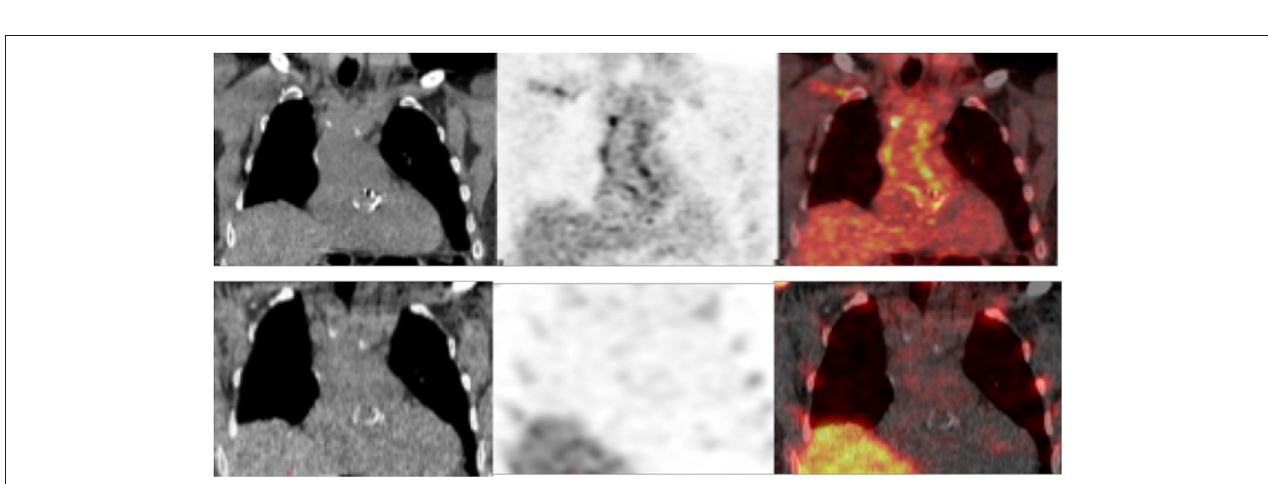
FIGURE 6 | Examples of discordant findings between [ 18 F]FDG PET/CT (upper panel, coronal view from left to right CT, emission and superimposed PET/CT) and 99m Tc labeled hexamethylpropylene amine oxime-WBC ( 99m Tc-HMPAO-WBC) (lower panel, coronal view from left to right CT, emission and superimposed SPET/CT) in a patient imaged 1 month after the Bentall procedure. PET/CT showed increased [ 18 F]FDG uptake at both the aortic valve and the vascular graft (diffuse pattern with areas of focal accumulation), while WBC SPECT/CT results negative. A 2-year follow-up excluded